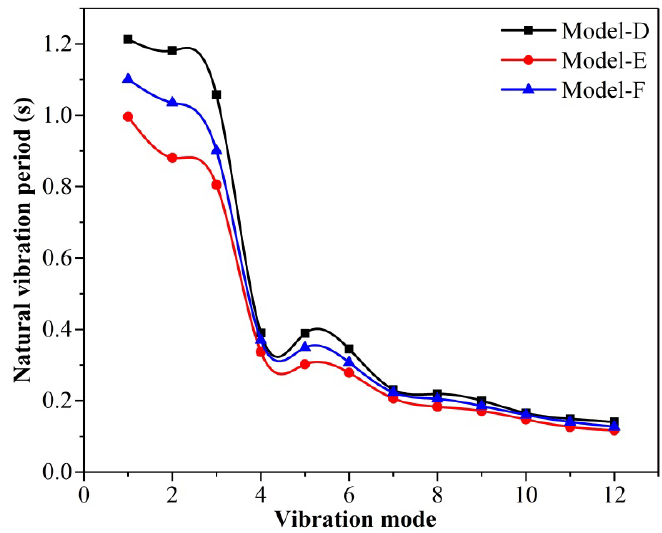
Figure 8. A comparison of the model’s natural period.